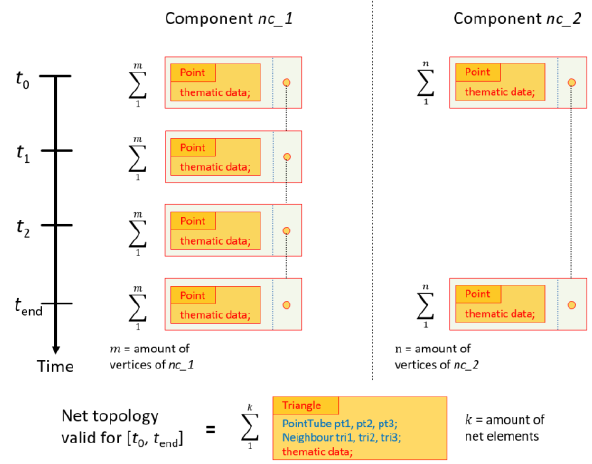
Figure 8. Point Tube data structure for two net components with different temporal discretizations